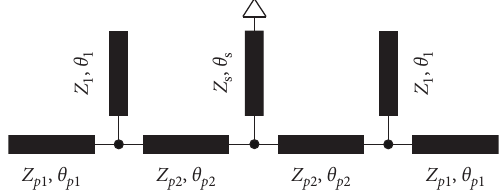
Figure 3: *e proposed equivalent model of symmetrical branch loaded